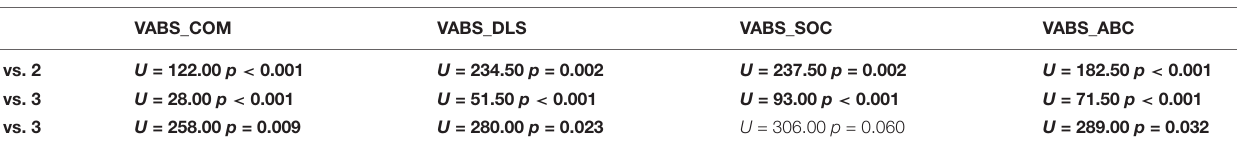
TABLE 3 | Post Hoc analysis (Mann-Whitney U